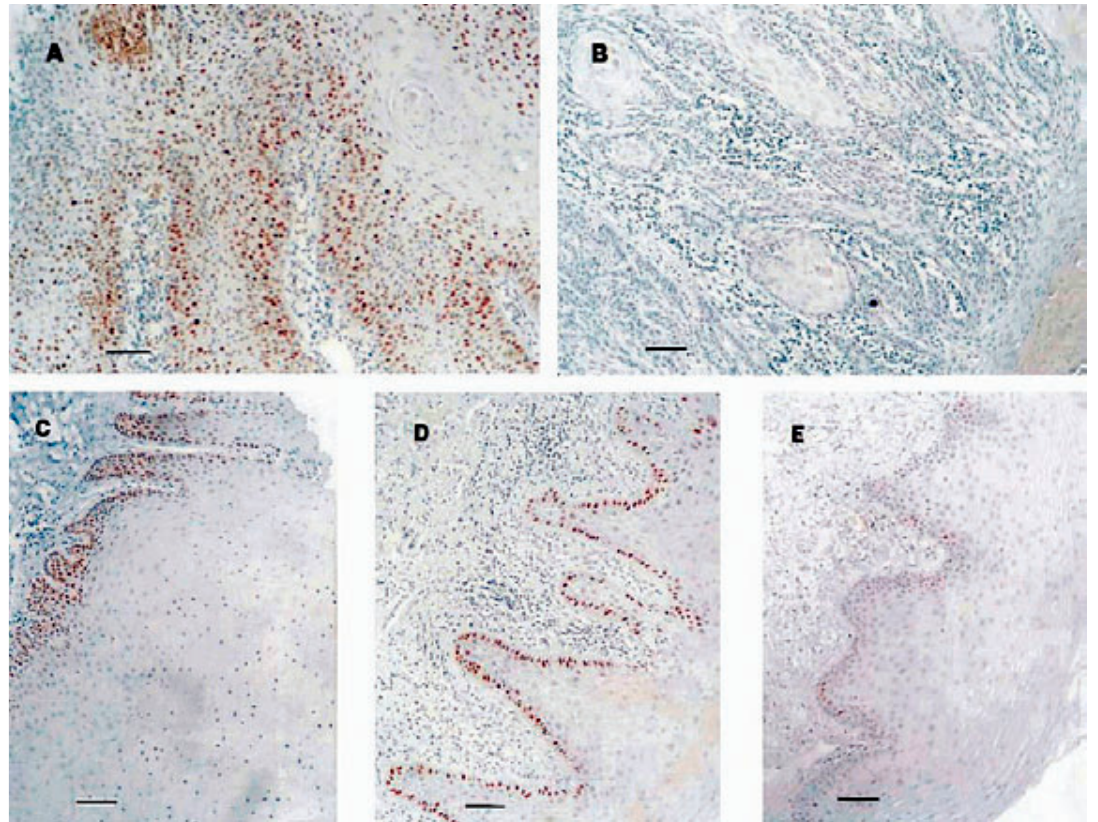
Figure 1. Expression of the TP53 protein in oral squamous cell carcinoma (OSCC), hyperkeratosis, lichen planus, and normal mucosa. ( A ) OSCC, positive staining, grade 1 (see text). ( B ) OSCC, negative staining. ( C ) Hyperkeratosis, positive staining, grade 2; note spreading of positive nuclei into suprabasal area. ( D ) Lichen planus, positive staining, grade 2; note that staining is confined to basal layer. ( E ) Normal mucosa, scattered staining, grade 4; scattered positive nuclei in basal layer. Bar, 50 mm. Reproduced with permission.